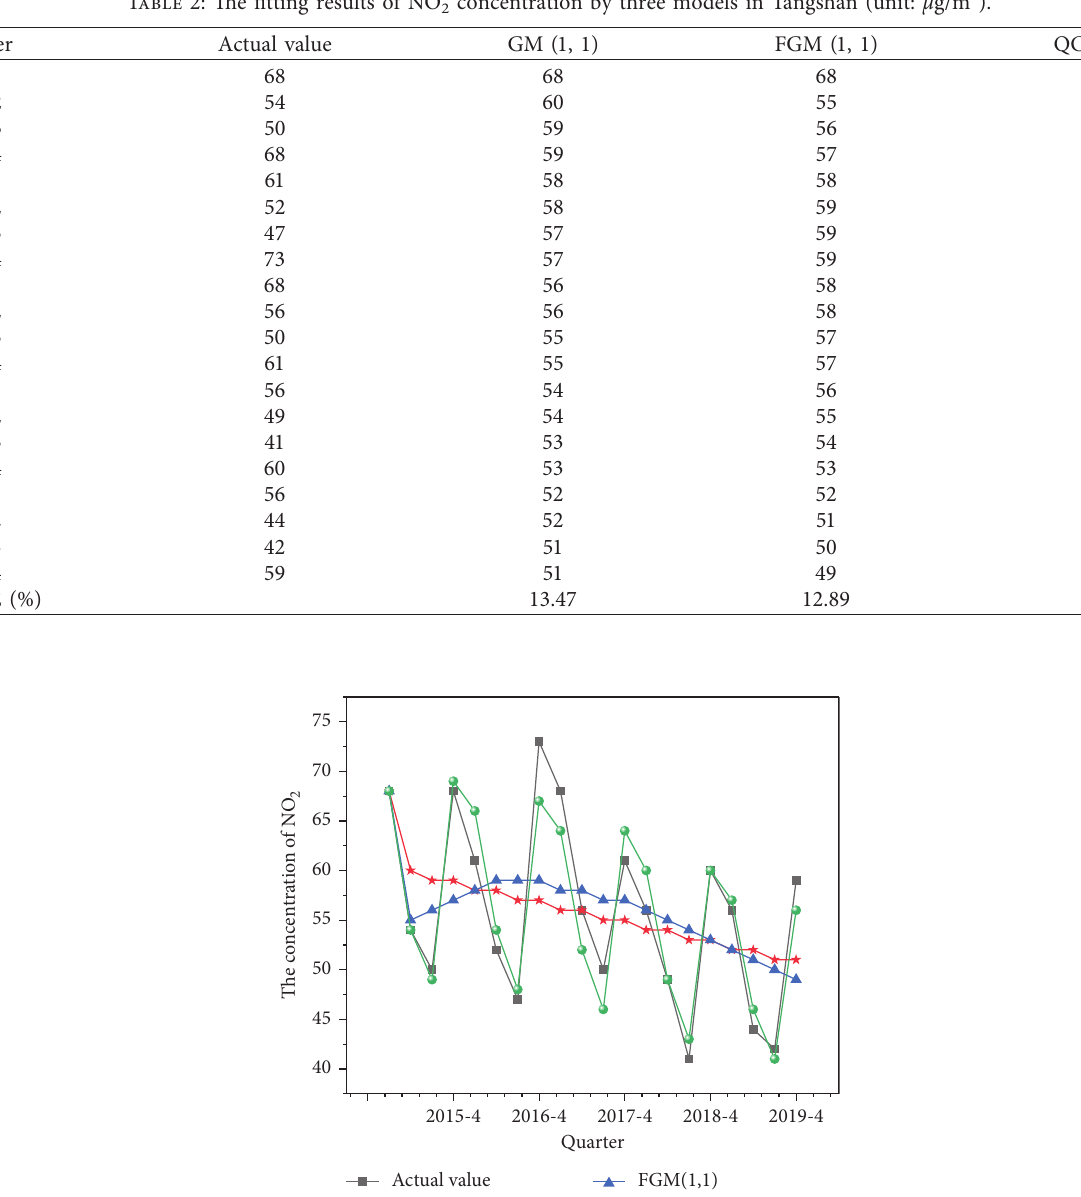
Table 2: The fitting results of NO